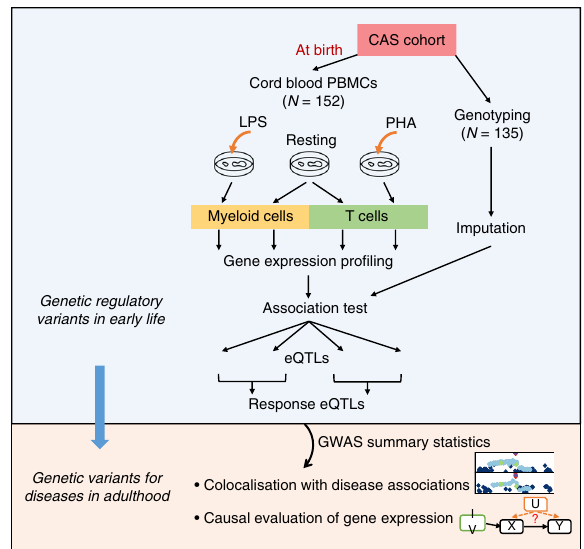
Fig. 1 Study design and analysis work fl ow. Monocyte/macrophage- enriched cultures (myeloid cells) and T-cell-enriched cultures were extracted from resting and stimulated cord blood samples from the Childhood Asthma Study (CAS) cohort. Gene expression was quanti fi ed using a microarray platform. Genotype data are available for a subset of the CAS individuals. eQTLs were identi fi ed within each experimental condition. Datasets for resting and stimulated samples were merged to detect response eQTLs within each cell type. Next, we identi fi ed genetic loci where neonatal eQTLs and disease associations obtained from external GWAS datasets shared the same causal variants. We investigated the causal effects of gene expression at birth on immune diseases that develop later in